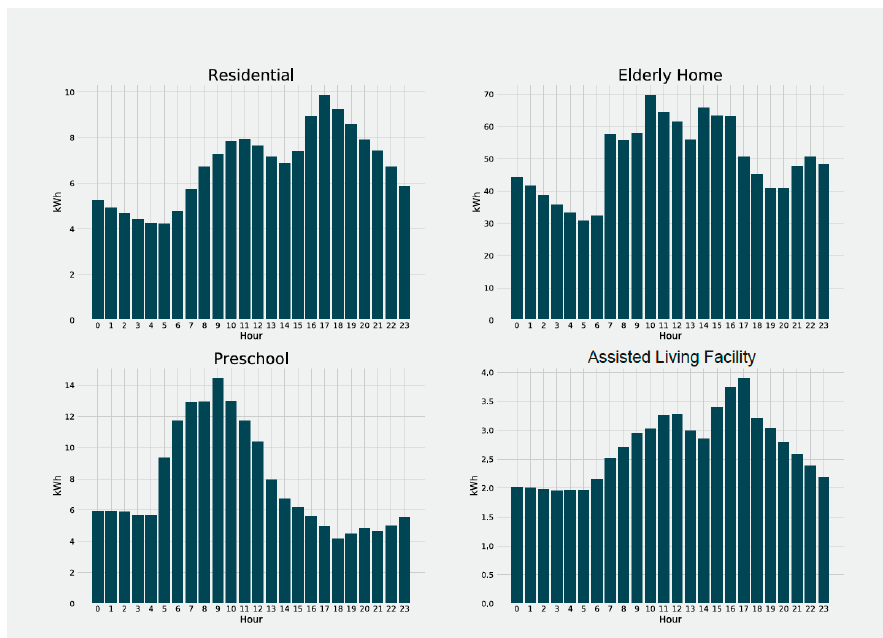
Figure 6. Different consumption profiles for the different sets of buildings, made by taking the mean of hourly data aggregated over the entire year.